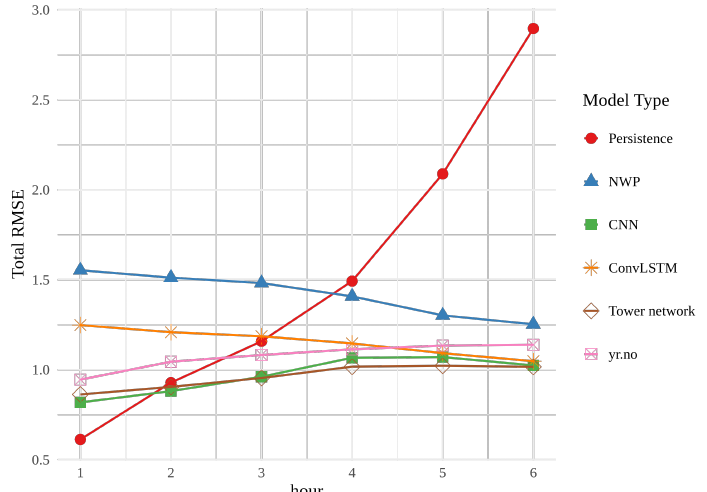
Figure 13. Comparison of the RMSE of the best realization of each neural network and meteorological baselines, all averaged over the spatial grid.